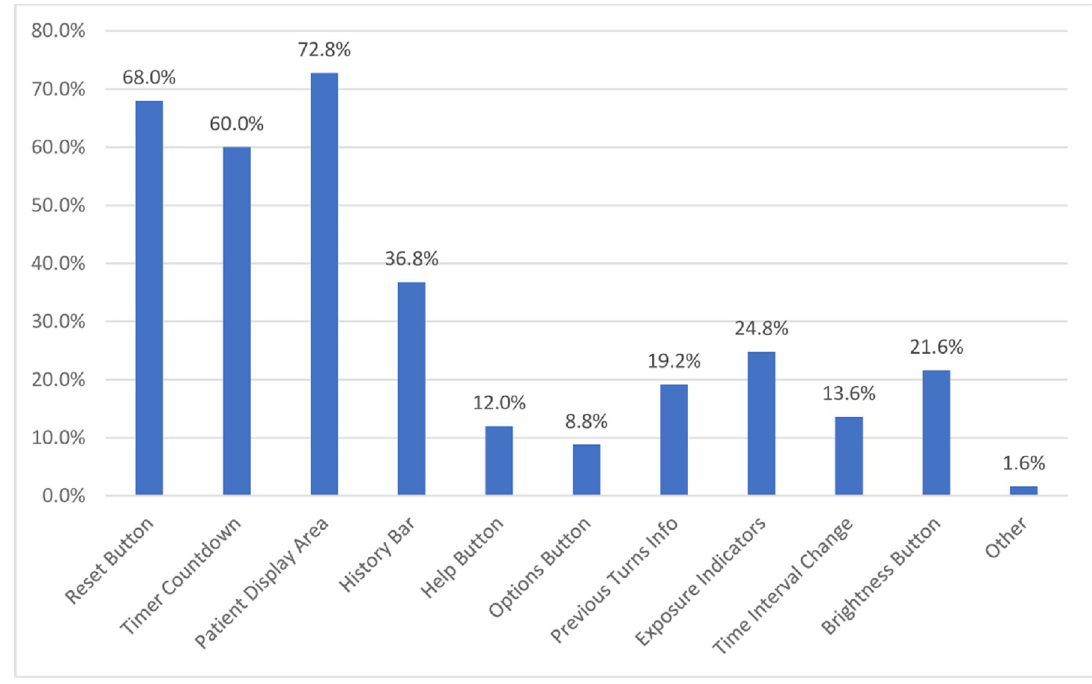
Fig 2. Features that healthcare providers liked about the pressure-sensing mattress cover